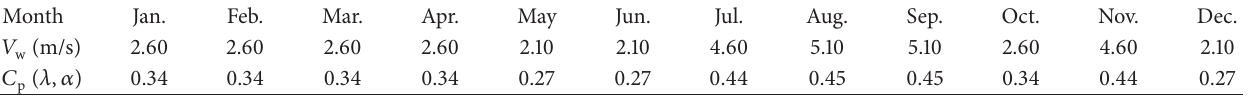
Table 1: Values of power coefficient for monthly wind speed recorded at Accra in 2013.